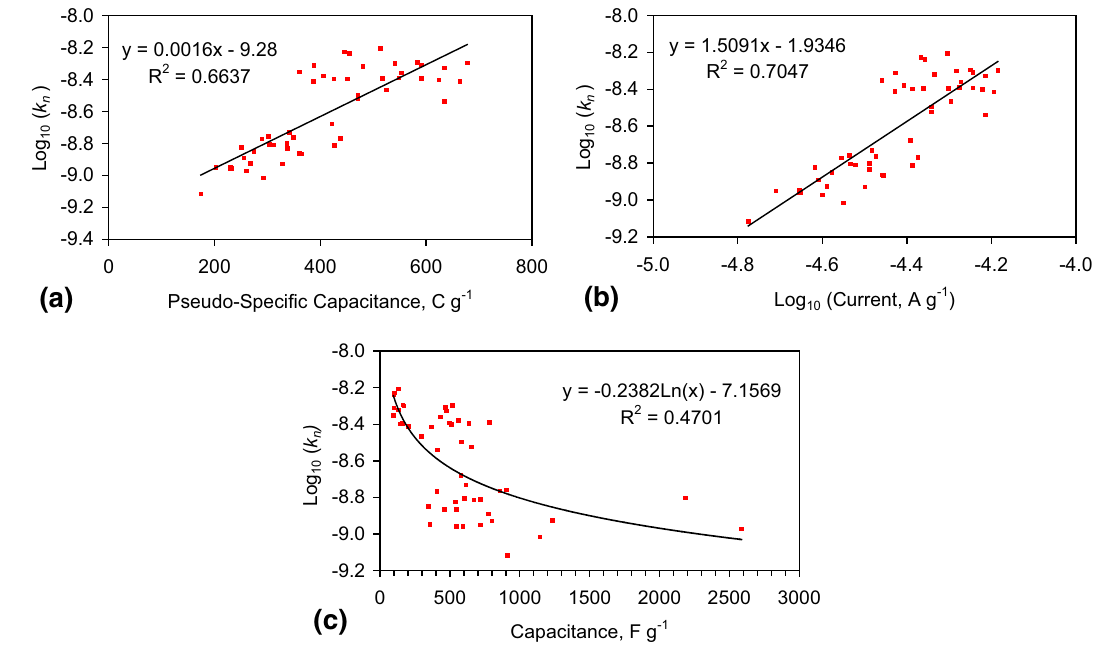
Fig. 5 Catalyst A: interpreted electrochemical parameters. a Pseudo-specific capacitance versus k Raw data source trials ST1a–ST5j (50 trials Antia 2015b)